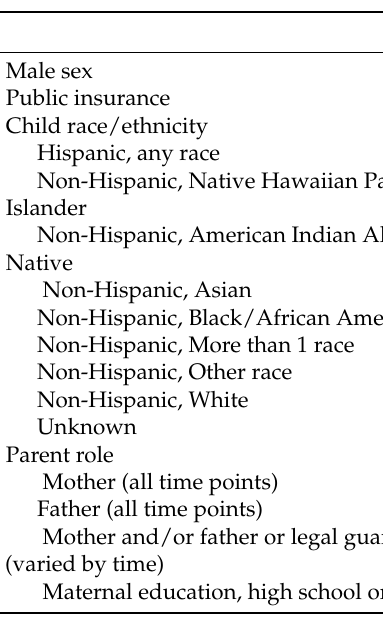
Table 1. Sample description (n =